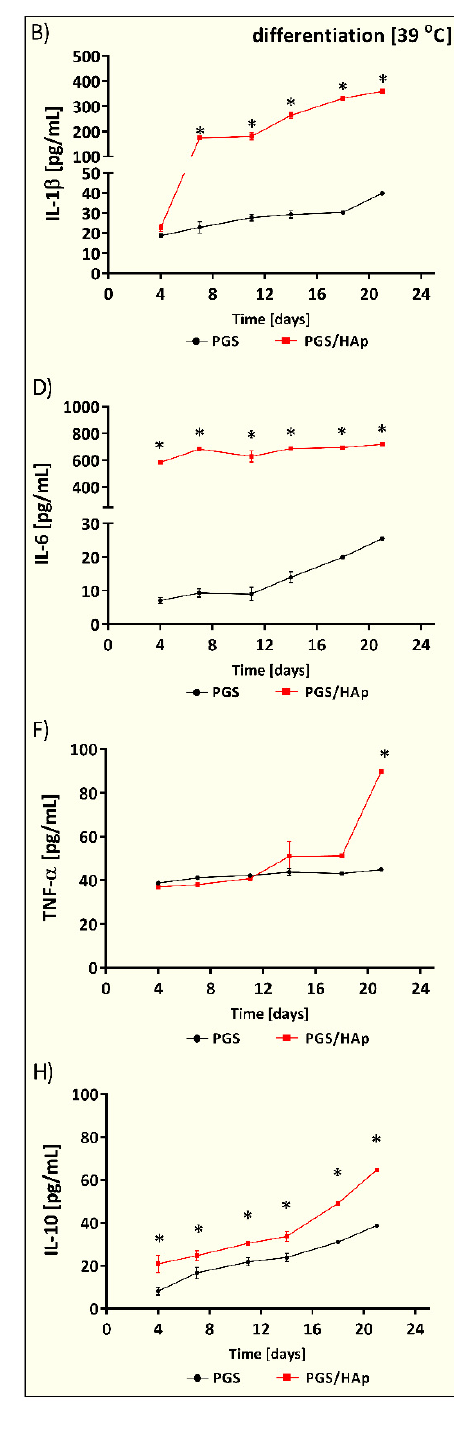
Figure 12. The concentrations of immunomodulatory cytokines relevant to bone homeostasis (IL-1 β ( A , B ), IL-6 ( C , D ), TNF- α ( E , F ) and IL-10 ( G , H )) assayed in the supernatants of hFOB 1.19 cultured on PGS or PGS/HAp scaffolds under a permissive temperature for growth (34 °C) or differentiation (39 °C), respectively. The results represent the mean concentration ± SD. * p < 0.05 between the PGS and PGS/HAp composites, the Mann–Whitney U test.